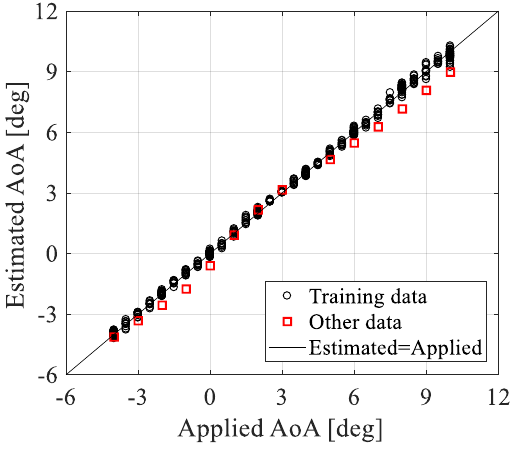
Figure 13. Comparison between applied and estimated AoA.